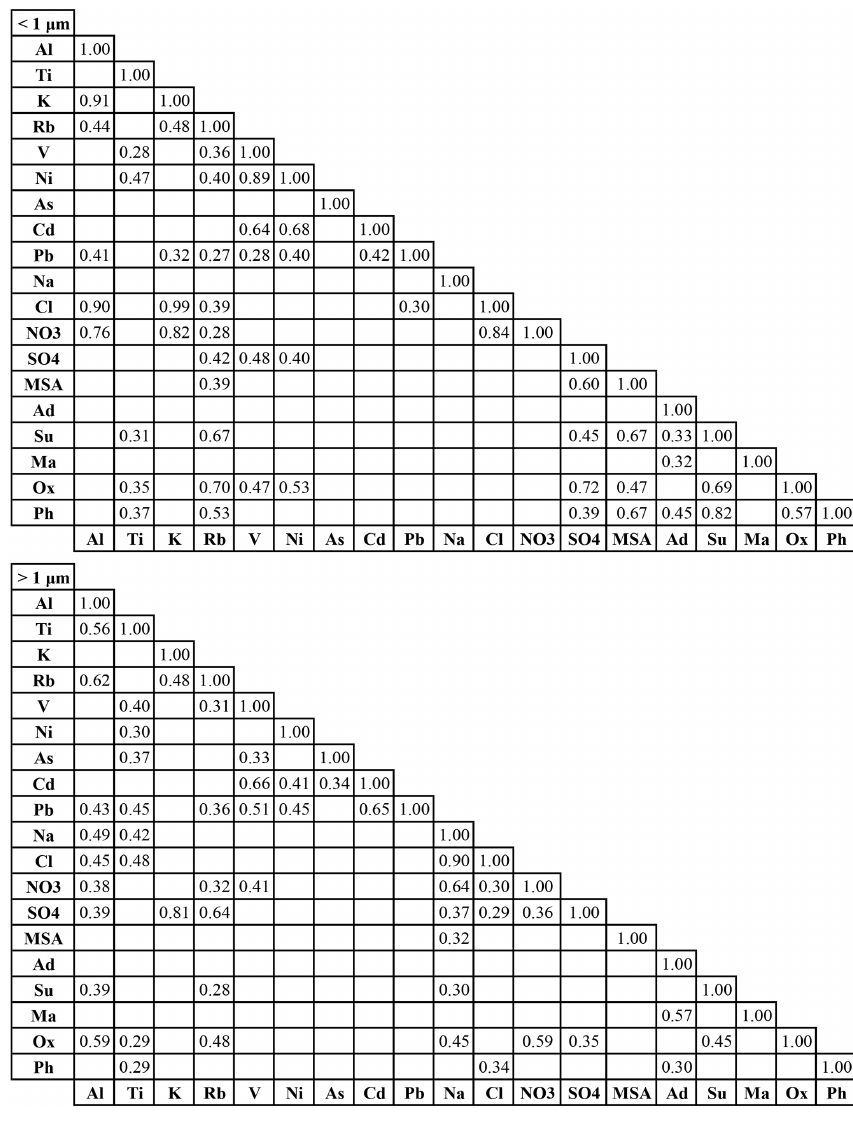
Table 3. Pearson’s correlation matrices ( r values) of water-soluble species for submicrometer (0.056–1.0µm) and supermicrometer (1.0– 18µm) sizes. Blank boxes indicate p values exceeding 0.05 and thus deemed to be statistically insignificant. Ad – adipate, Su –